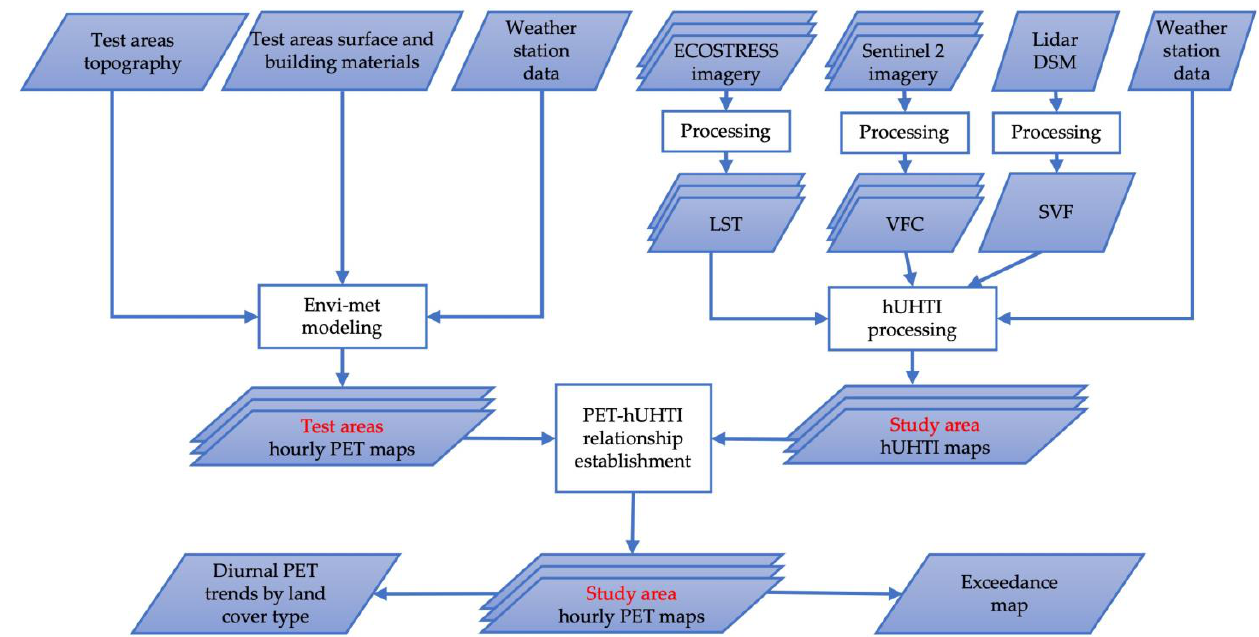
Figure 3. Flowchart of implemented methodology (DSM = digital surface model; LST = land surface temperature; VFC = vegetation fraction cover; SVF = sky view factor; PET = physiological equivalent temperature; hUHTI = hourly urban heatwave thermal index).